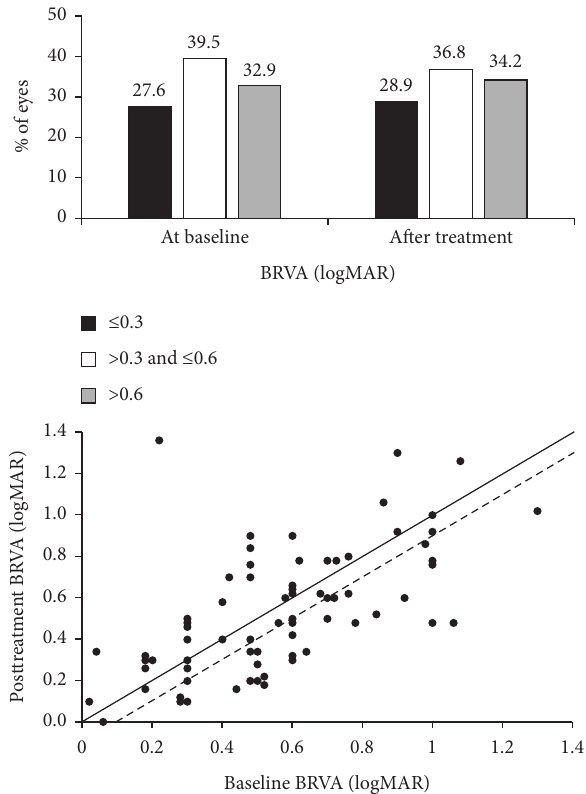
Figure 2: Best-recorded visual acuity at baseline and after 6 intravitreal anti-VEGF injections. Notes: the solid line represents the 45-degree line, and the dashed line represents a 0.1 logMAR (5 letters) change from the 45-degree line following treatment. Mean baseline BRVA was 0.55 ± 0.27 logMAR (mean ± SD), and there was a nonsignificant improvement ( P � 0 . 269) to 0.52 ± 0.30 log- MAR after anti-VEGF treatment. Black filled bars show BRVA ≤ 0.3 logMAR, open bars > 0.03 and ≤ 0.6 logMAR, and grey filled bars > 0.06